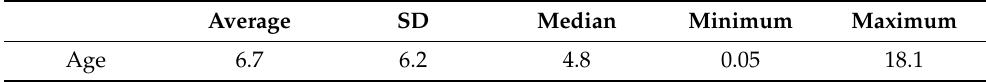
Table 1. Age distribution in years in the group.